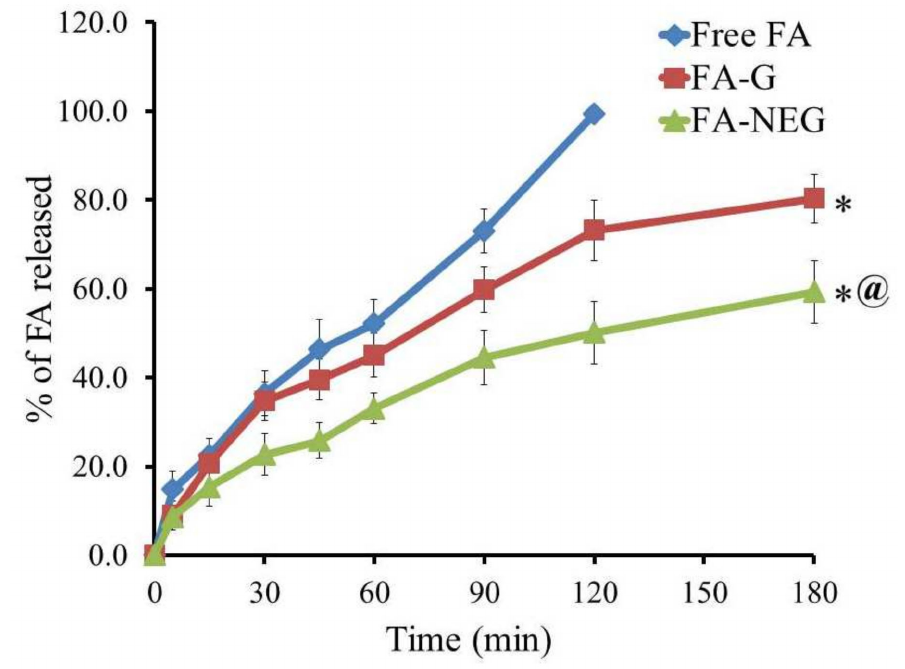
Figure 9. Outline of in vitro release of FA from FA-G and FA-NEG compared to FA as a free drug, using pH 5.5 phosphate buffer at 32 ± 0.5 ◦ C. Results are expressed as the mean ± SD of three trials; * p < 0.05 compared to free FA; @ p < 0.05 compared to the FA-G